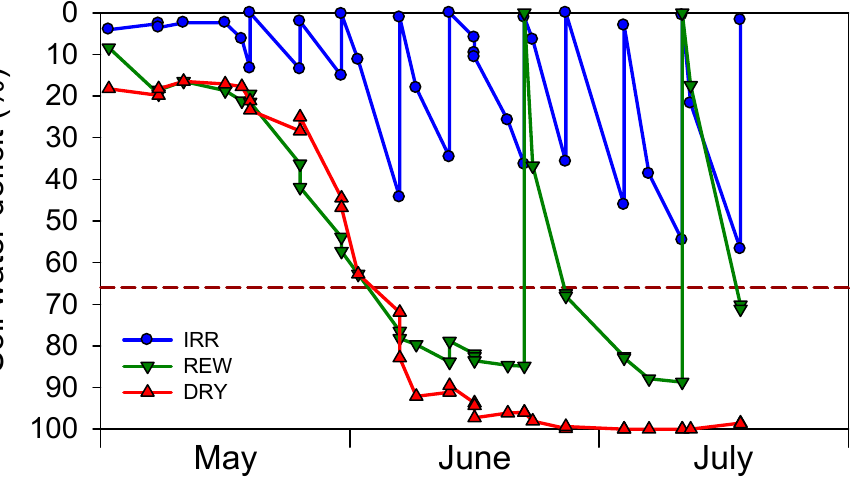
Figure 2. Soil water deficit at a depth of 0.40 m in each irrigation treatment. Constant horizontal short dash line indicates minimum threshold of available soil water content.